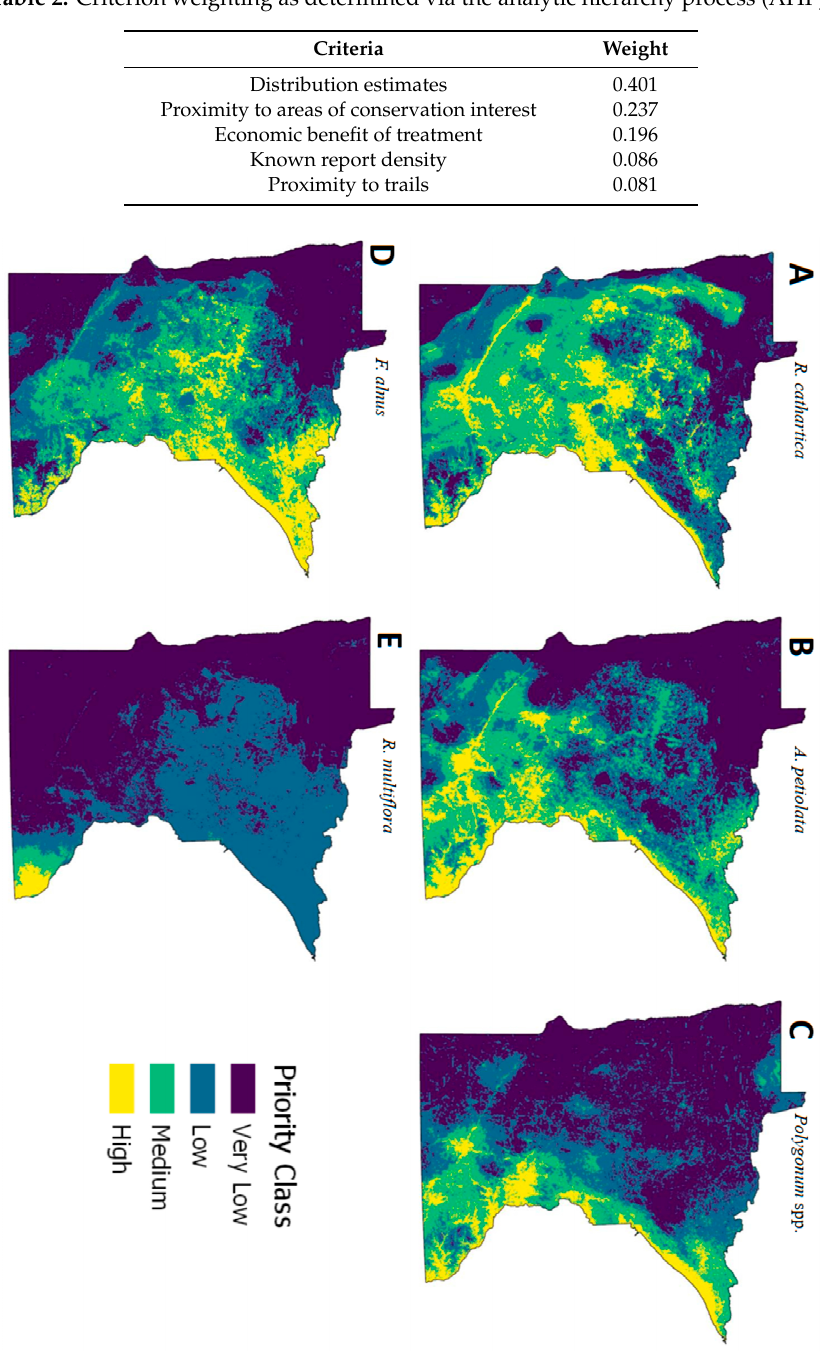
Figure 2. Prioritization maps for ( A ) R. cathartica , ( B ) A. petiolata , ( C ) Polygonum spp., ( D ) F. alnus , and ( E ) R. multiflora . Prioritization classes created from continuous multi-criteria decision analysis (MCDA) output using Jenks’ natural breaks optimization.